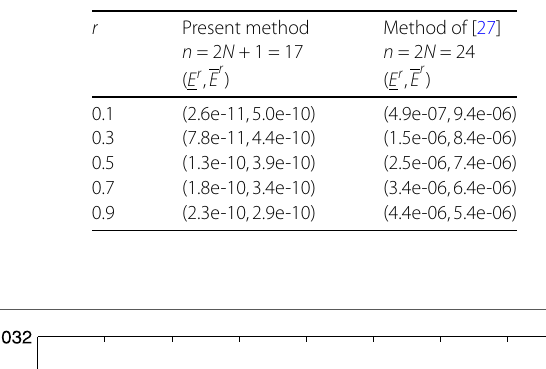
Table 4 Comparison of methods with ( x , y ) = (0.1.0.4) of Example 5.2